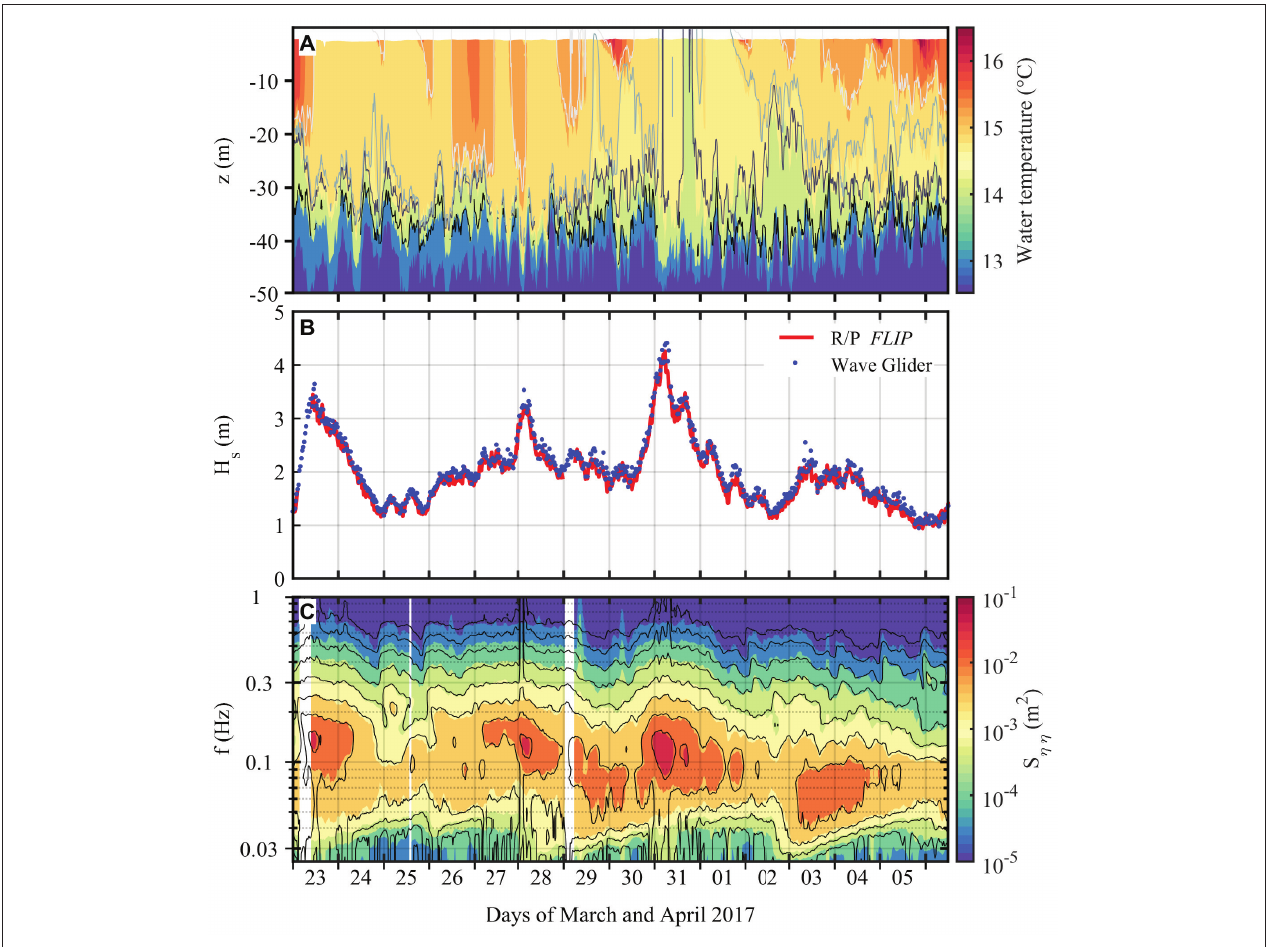
FIGURE 3 | (A) Time evolution of the water temperature during the LCDRI2017 experiment measured by the thermistor chains mounted on the SV2 Wave Glider Kelvin and on the R/P FLIP . Colormap and contour lines correspond to data from the R/P FLIP and from the SV2 Kelvin , respectively. The white contour line corresponds to 15.2 ◦ C, light gray is 14.8 ◦ C, dark gray is 14.65 ◦ C, and black is 14.0 ◦ C. Direct comparison of 20 min averaged water temperature between the two instruments gives a coefficient of determination r 2 0.8 0.03. (B) Significant wave height H s and (C) omni-directional spectrogram of the wave field measured from = ± the R/P FLIP and the SV2 Wave Glider Kelvin during LCDRI2017. In (C) , the colored map and black contours are from the R/P FLIP and the Wave Glider, respectively. The significant wave height H s is computed from the integration of the omni-directional spectrum, both being computed over 30 min long records. For the R/P FLIP , S ηη is computed from a single laser wave gauge, while for the Wave Glider, the surface elevation is assumed to be described by the vertical displacement (heave motion) of the Wave Glider. The coefficient of determination r 2 for H s is equal to